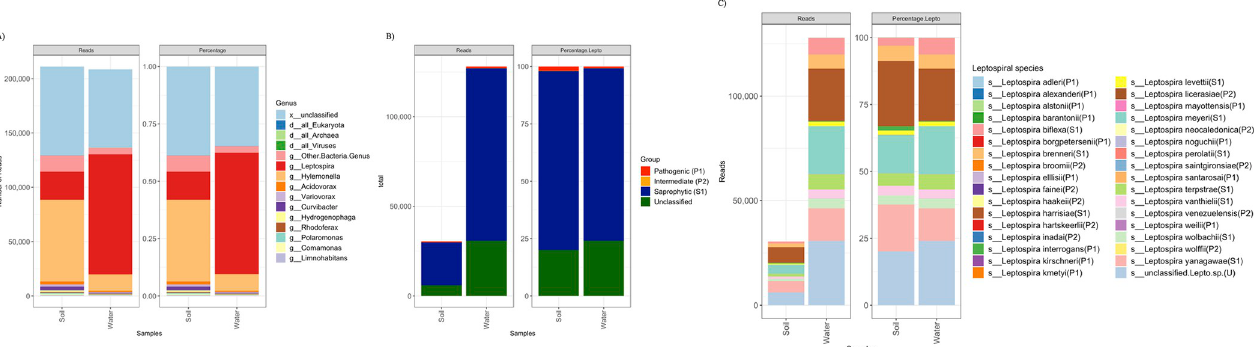
Fig 3. Microbial classification summary statistics of pooled enrichment cultures of soil and water samples. A) The overall microbial compositions classified in the culture enriched soil and water samples. B) The number and percentage of different clades of Leptospira reads identified in the soil and water samples. C) The number and percentage of reads classified under different Leptospira species in enrichment cultures sequenced are presented. Clade of each Leptospira species is annotated in the parenthesis behind species names (P1: Pathogenic; P2: Intermediate; S1: Saprophytic 1; U: Unclassified). 3A: General microbial profile, 3B: Proportion of Leptospira clades identified, 3C: Leptospira species-level classification.